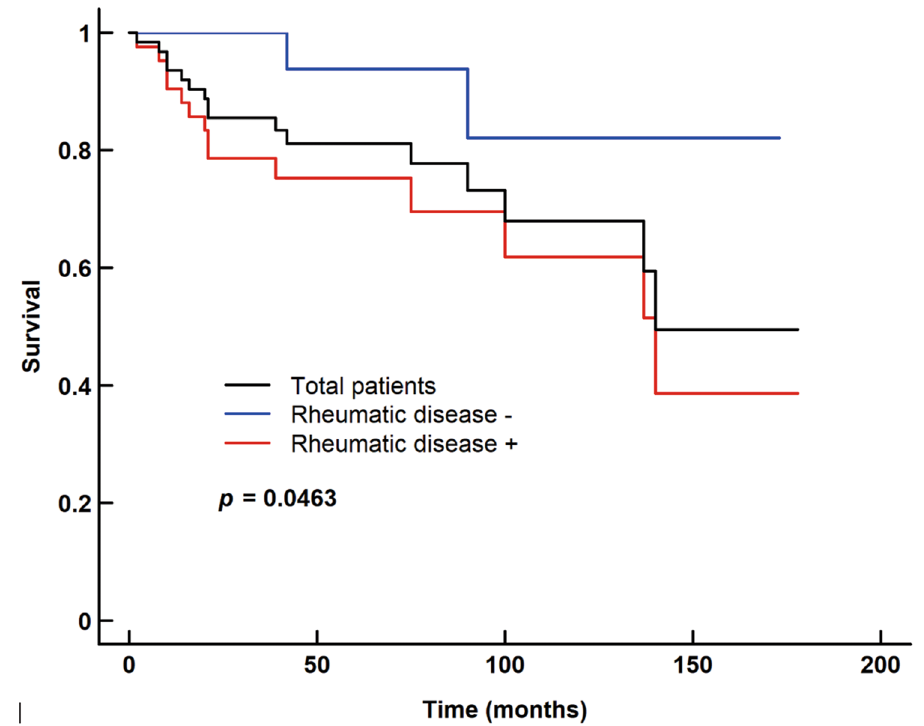
Figure 1. Kaplan–Meier survival curves of symptom-free